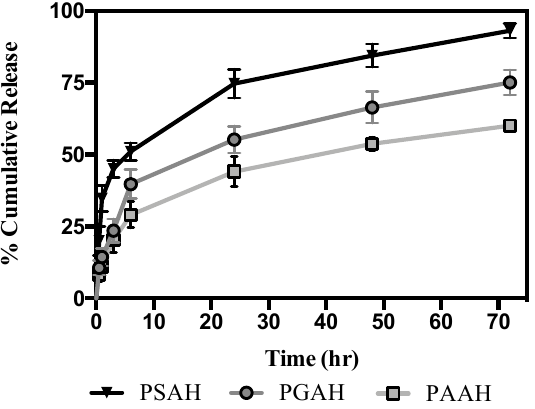
Figure 5. SEM micrographics of PSAH ( A ), PGAH ( B ), and PAAH ( C ).